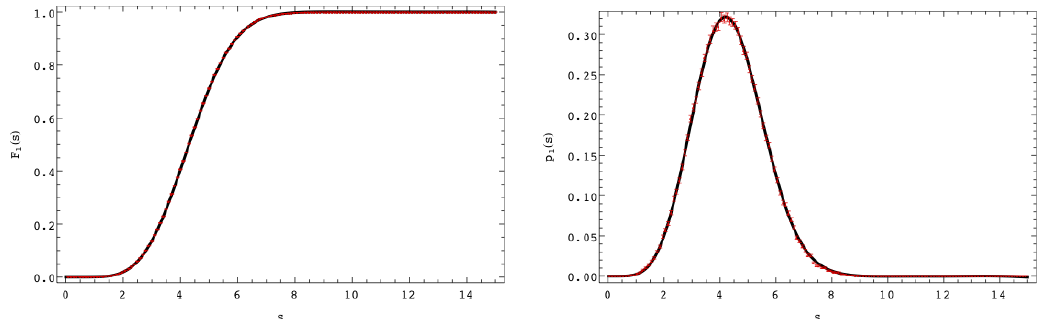
Figure 2 . Plots of F 1 ( s ) (left) and p 1 ( s ) (right) for the chiral GUE with N f = 2 doubly-degenerated masses (cid:22) 1 = 0 : 1 and the topological charge (cid:23) = 0 are depicted. In this computation, the quadrature of order M = 5 is used to discretize the Fredholm determinant (3.1). On both plots, data obtained with Monte Carlo simulation with matrix rank N = 1000 is overlaid (red symbol with error bar, though the error in the left panel is hard to recognize by